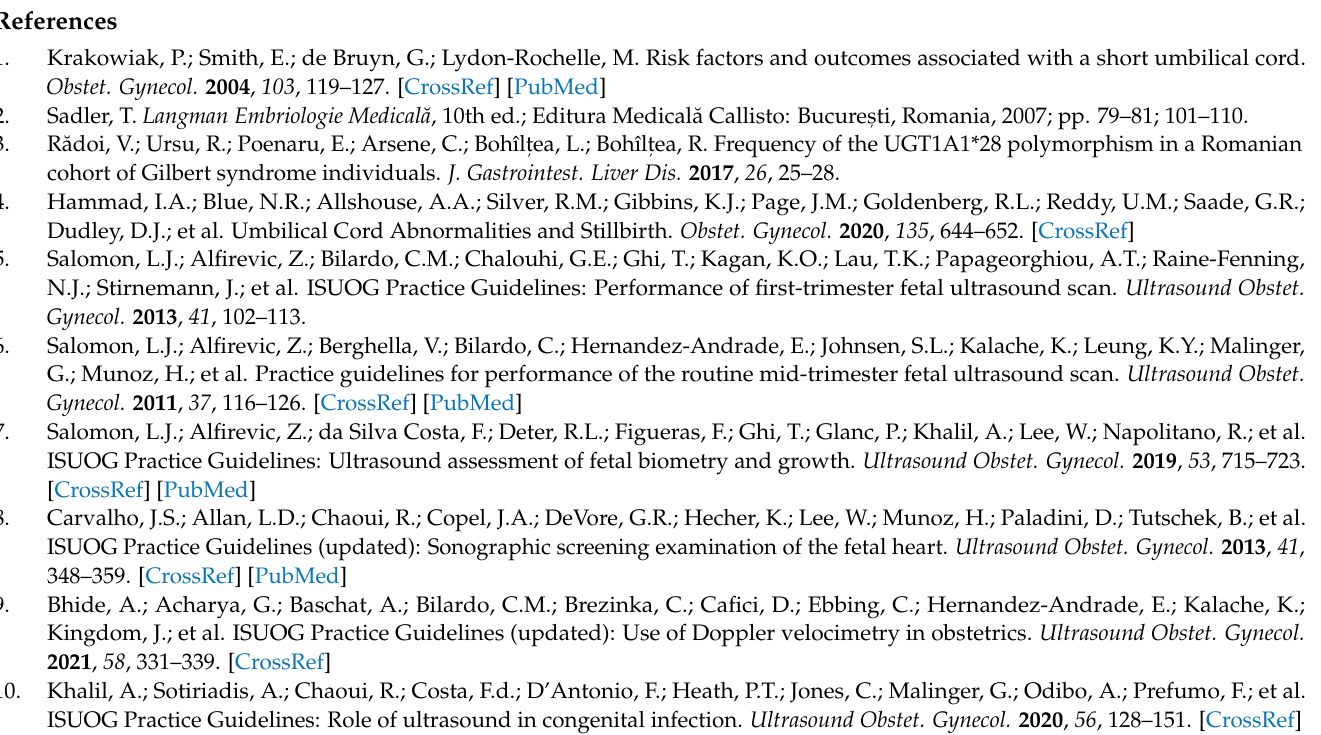
clinical practice; Figure S2: three-dimensional imaging of varix cords; Figure S3: cystic abnormalities; Figure S4: coiling pathologies: lax cord; Video S1: